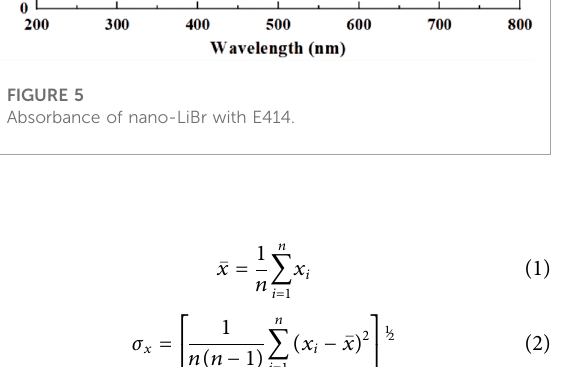
Where, σ x is the standard deviation; n is the number of experimental data measurements; x i is the data value of the measurement, and (cid:1) x is the arithmetic mean of each group ’ s experimental data measurements.